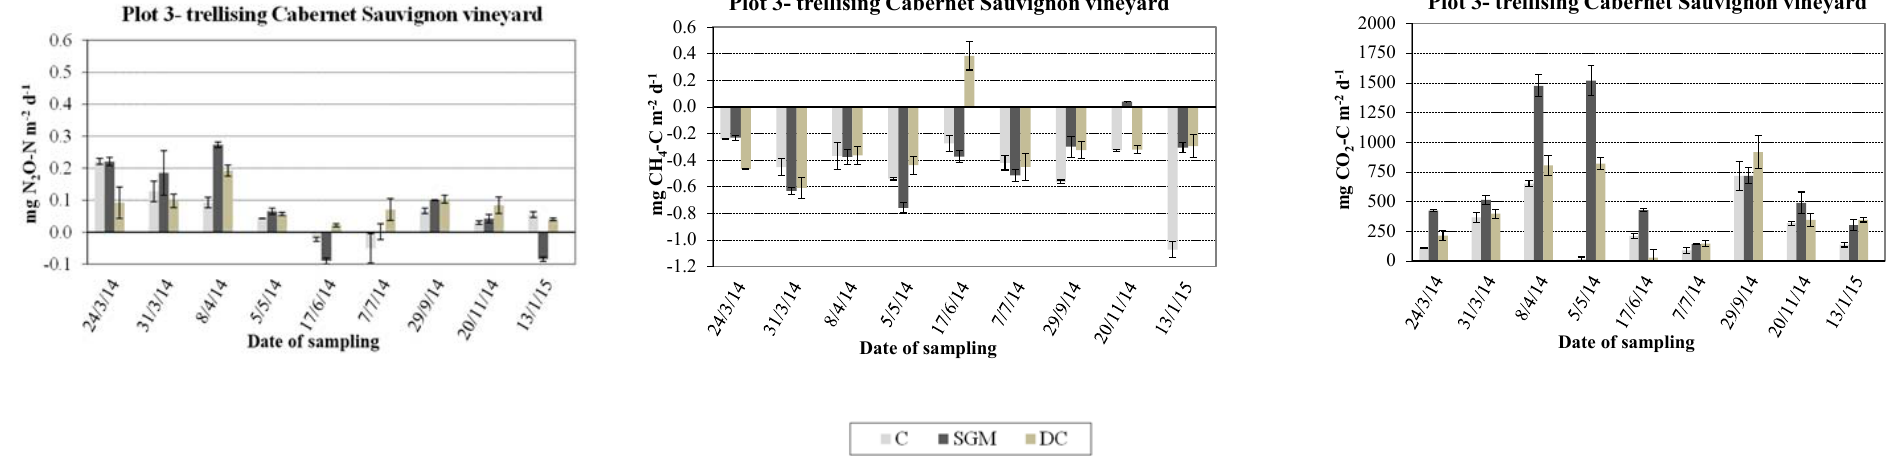
Figure 6. Changes over time in the N 2 O ( A ), CH 4 ( B ) and CO 2 ( C ) fluxes. Error bars represent the standard error of the mean. (C: control, SGM: sheep/goat manure and DC: distillery organic waste compost).